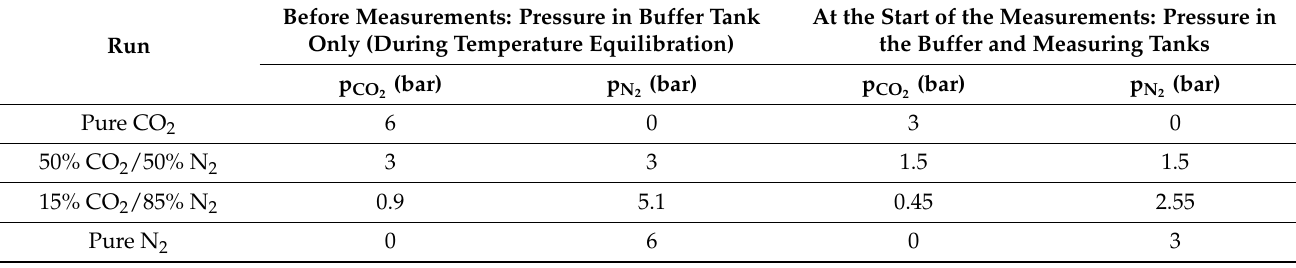
Table 1. Partial pressures of CO 2 and N 2 and the total pressure applied in the selectivity tests. Before Measurements: Pressure in Buffer Run